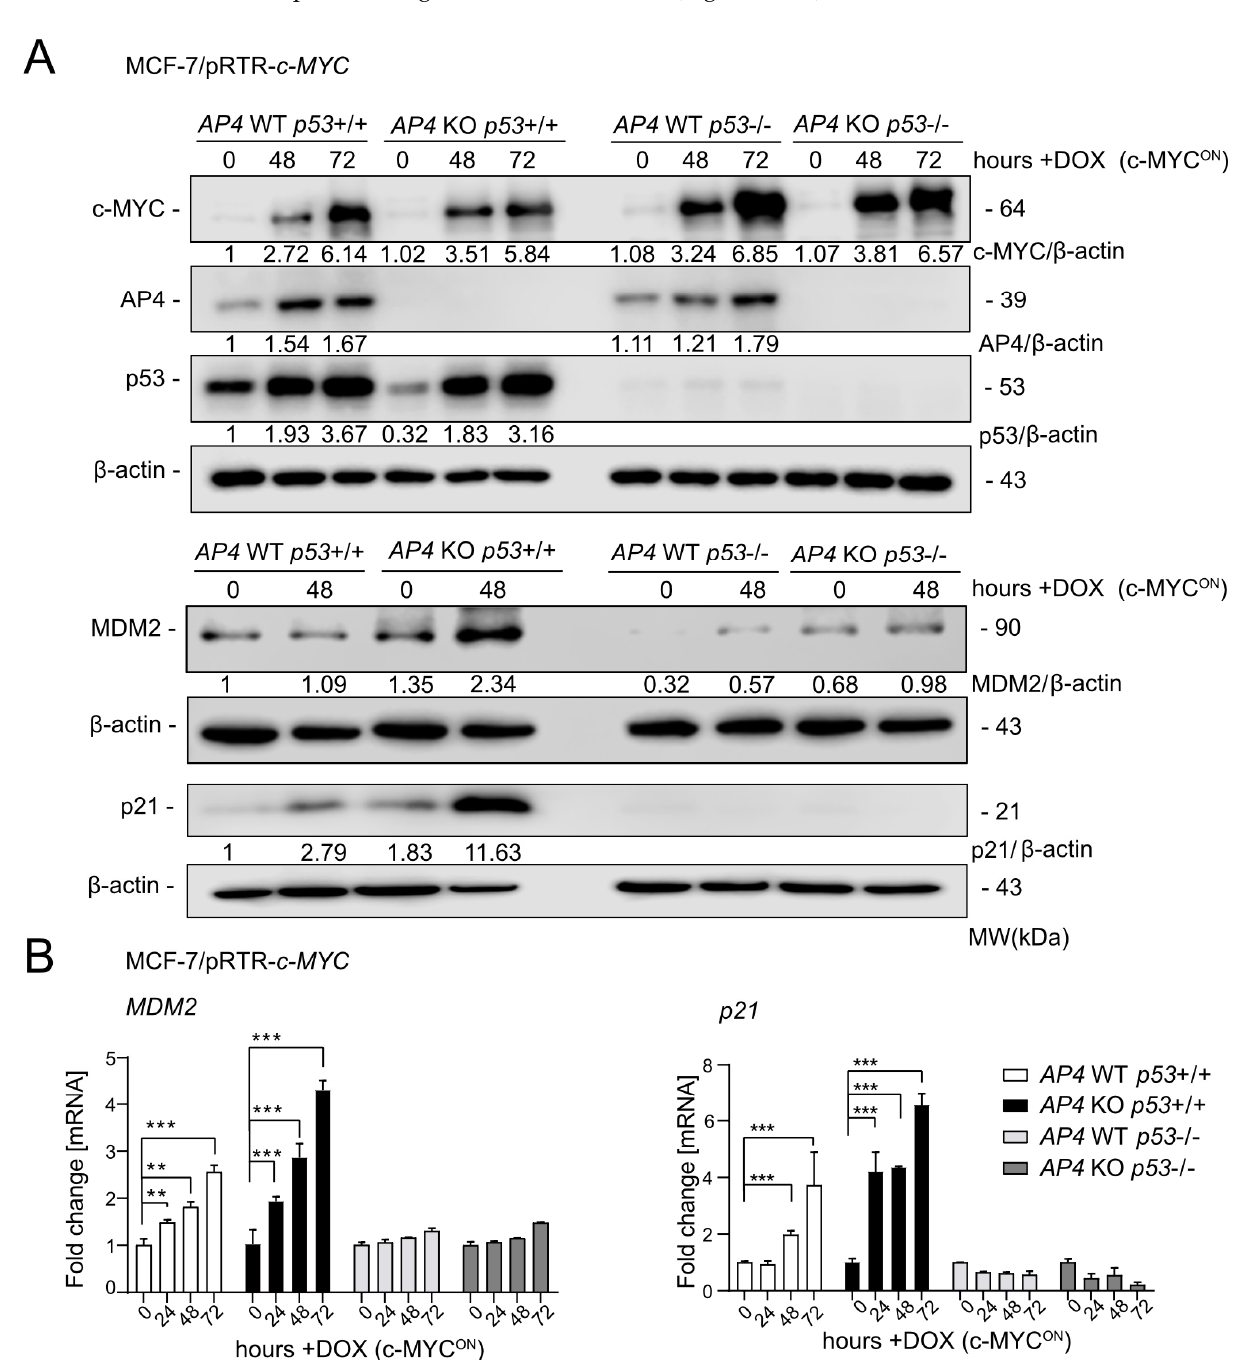
Figure 1. Effects of AP4 and/or p53 deletion on p21/CDKN1A and MDM2 expression after activation of c-MYC. ( A ) Western blot analysis of the indicated cells after treatment with DOX for the indicated periods. β -actin served as a loading control. ( B ) qPCR analysis of the indicated cells after treatment with DOX for the indicated period. The mean +/ − SD ( n = 3) is provided with **: p < 0.01, ***: p < 0.001. The uncropped blots are shown in Figure S1.